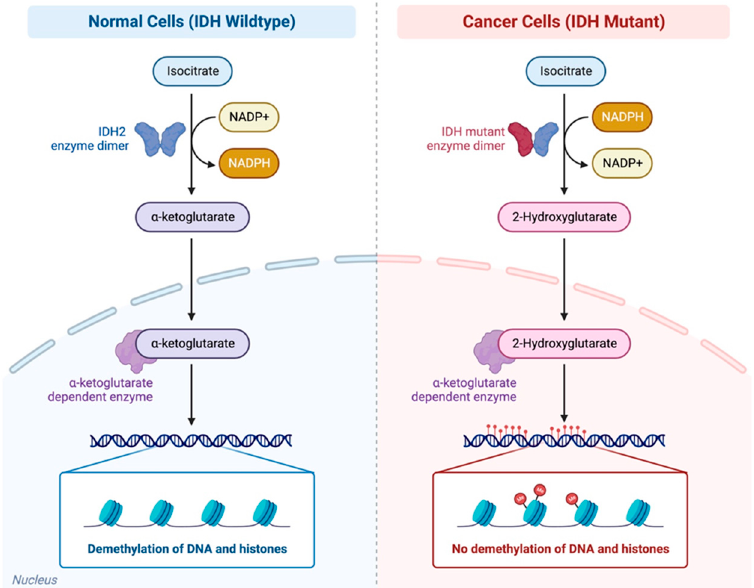
Figure 2. Differences between normal cells with IDH wildtype and cancer cells with IDH mutant. Mutant IDH proteins result in an abnormal enzymatic activity, allowing them to convert α -ketoglutarate ( α KG) to 2-hydroxyglutarate (2HG), which inhibits the activity of multiple α KG-dependent dioxygenases. These alterations result in the impairment of the DNA, and histone demethylation. Figure created with BioRender.com.